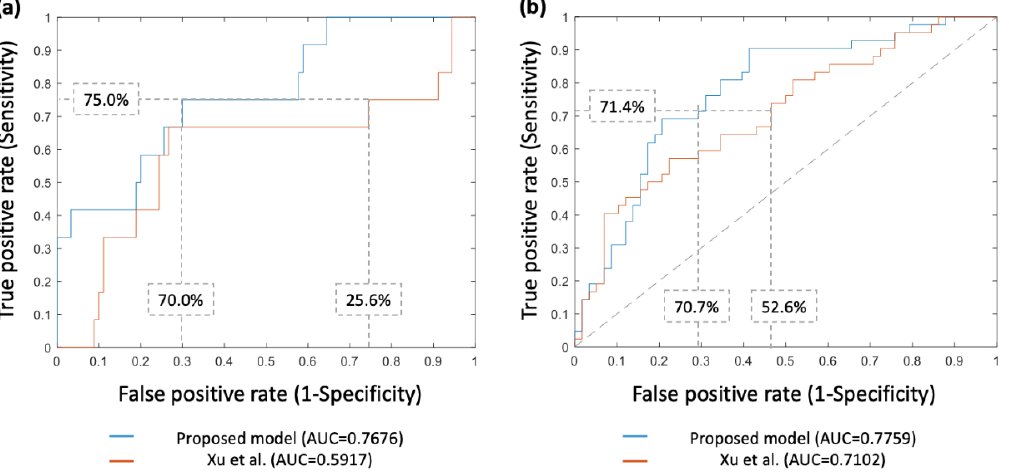
Figure 5. Receiver operating characteristics curves of tumor invasiveness prediction for pure ground-glass nodules (pGGNs) lung adenocarcinoma using the proposed and previously published models from Xu et al. [34] in ( a ) the internal validation (i.e., leave-one-out cross-validation) and ( b ) the external validation. ROC, receiver operating characteristic; AUC, area under the curve. Table 5. Demographic and clinical features of the additional pGGN cohort for external validation.